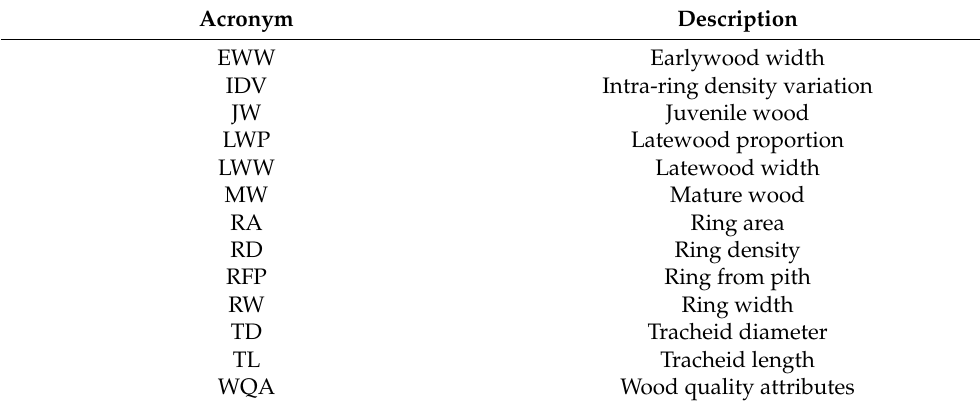
Table 1. Acronyms used in the text and their